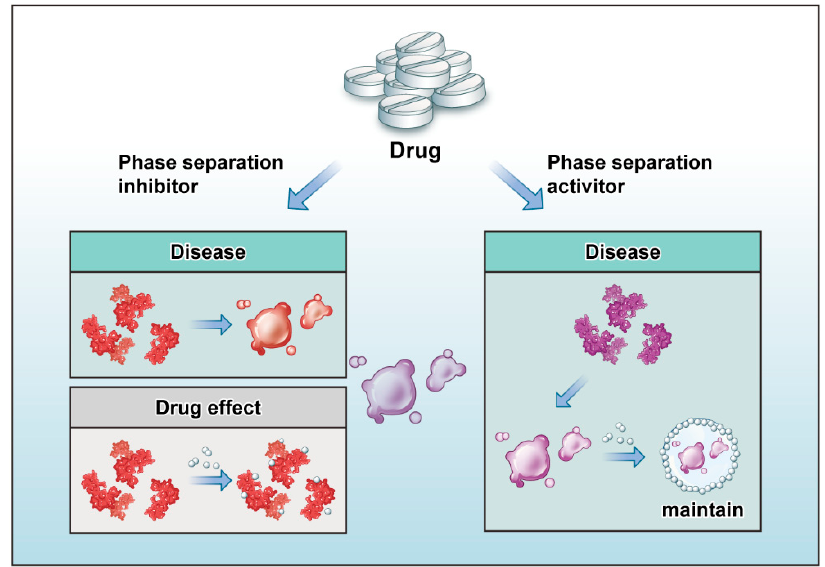
Figure 3. Possible ways through which drugs affect phase separation. Possible ways through which drugs promote/inhibit phase separation: (1) drugs may act as short peptide inhibitors of phase separation and inhibit phase separation through competitively binding to key sites of phase separation; (2) drugs can maintain phase separation by adjusting the external environment of phase separation, such as pH, salt concentration, etc.